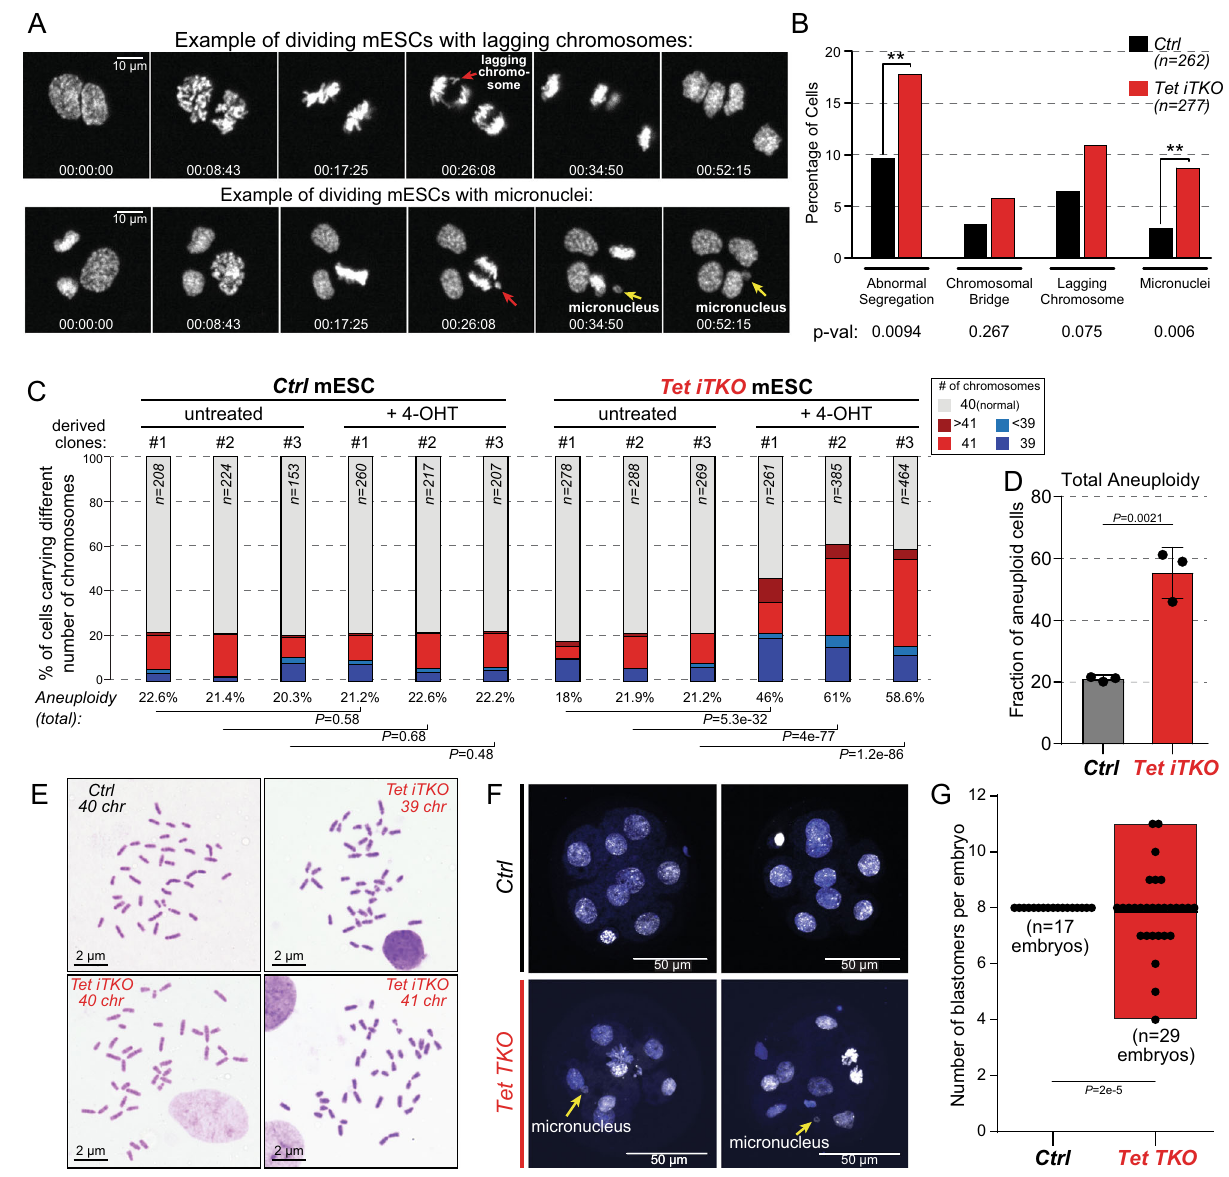
Fig. 2 | Appearance of aneuploidies and chromosome segregation defects in triple TET-de fi cient embryos and mESC. A Time-lapse microscopy of single cells progressing through mitosis. Top panel, image of a lagging chromosome (red arrow) during anaphase. Bottom panel, images of a lagging chromosome (red arrows) engendering micronuclei (yellow arrows) after completion of mitosis. Relative times are shown as time stamps at the bottom of each panel representing the time elapsed between each snapshot for two independent movies. B Quanti fi cation of chromosome mis-segregation data after acute Tet1/2/3 gene deletion in mESC. Live-cell imaging was performed over 48h (days 4 – 6 after addition of 4-OHT), and abnormal chromosome segregation and the presence of micronuclei were quanti fi ed. Cochran-Mantel-Haenszel test was performed to cal- culate p -values from two independent experiments (** p <0.01). C Ploidy analysis calculated from metaphase spreads of Ctrl versus acutely-deleted Tet iTKO mESC, 6.5daysafterexposureto4-OHT).Percentagesofeuploid(gray,40chromosomes) and aneuploid mESC are represented as bar graphs showing hyperploid cells (>40 chromosomes) in shades of red and hypoploidcells(<39 chromosomes) in shades ofblue.Chi-squaretestwasperformed,andthecalculated p -valuesareincludedfor